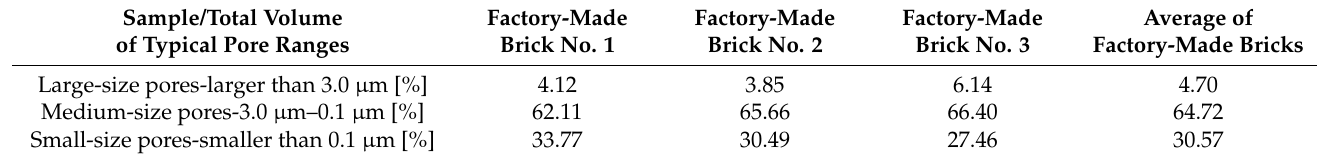
Table 4. The pore size ranges of factory-made bricks.